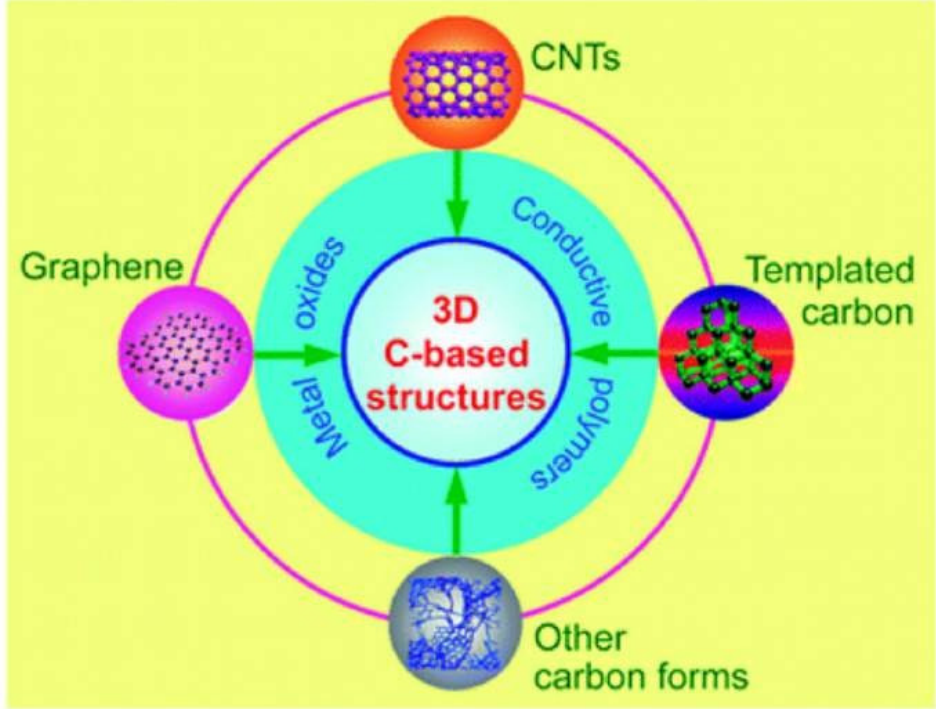
Figure 8. Different kinds of carbon combined with 3D carbon-based nanostructures and pseudo- active materials. Reproduced with permission from [72].